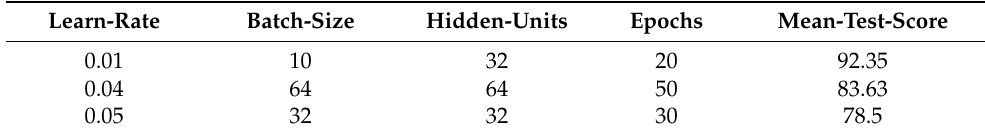
Table 3. Representation of optimised hyperparameters with different test-scores using Grid Search Op-